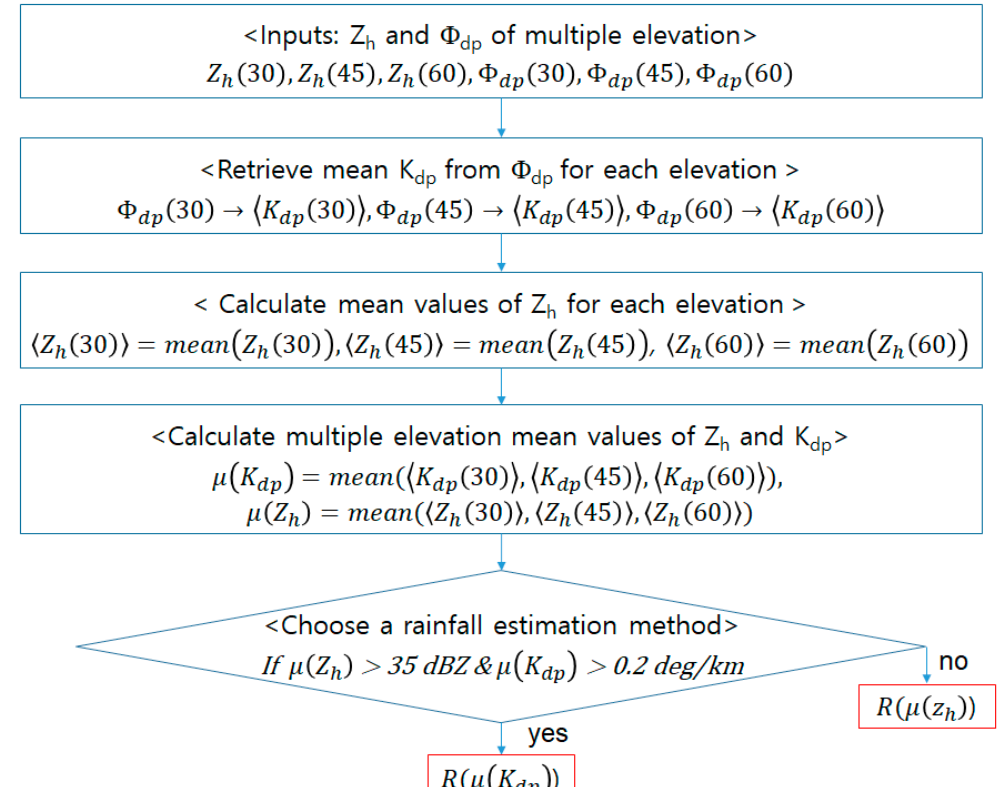
Figure 5. Flowchart showing the process for estimating average rainfall of the EWRG.